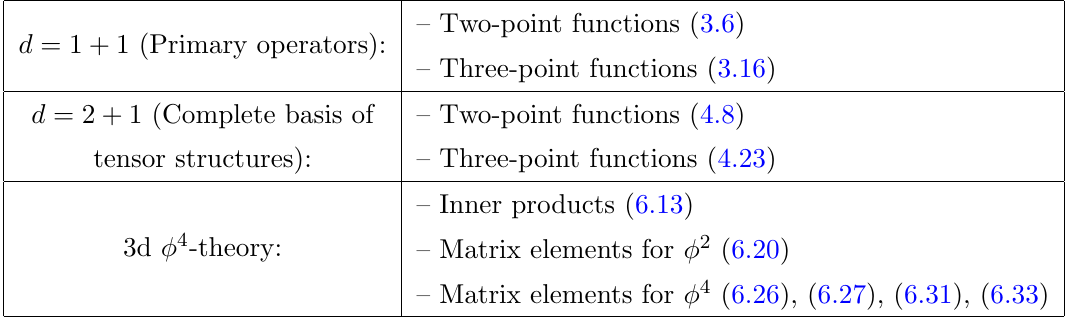
Table 1 . Summary of